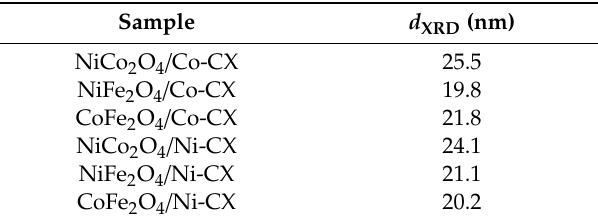
Table 2. Mean particle size obtained from Scherrer equation.